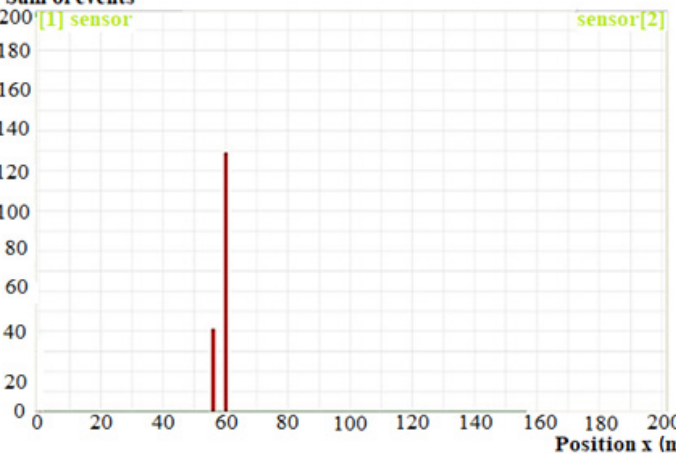
Figure 15. Exact location of destructive process sources.